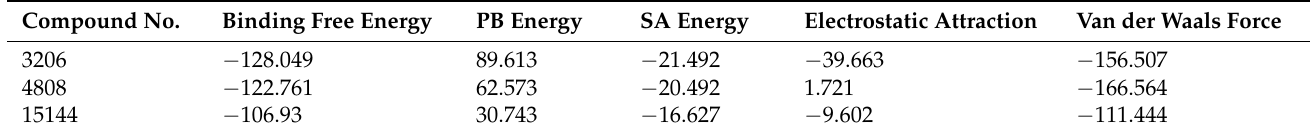
Table 3. Results of the MM/PBSA calculation.